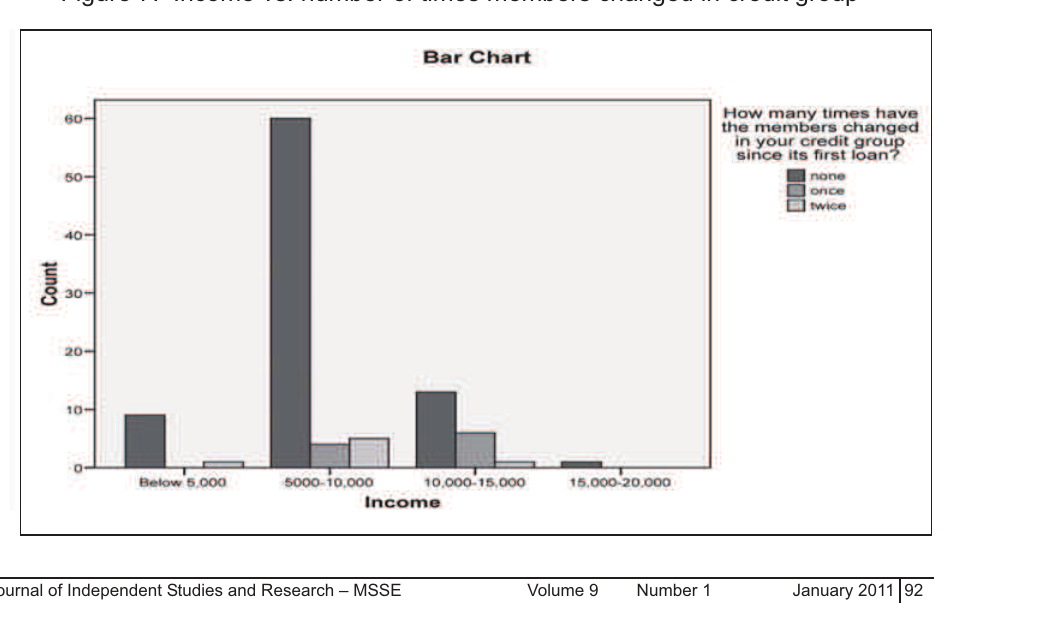
Figure 7. Income vs. number of times members changed in credit